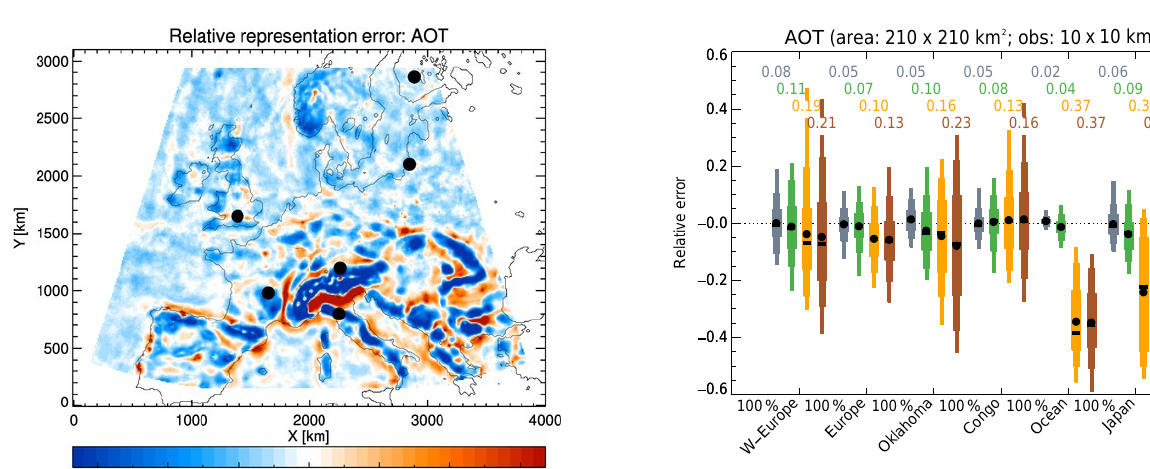
Figure 6. Analysis of monthly representation errors for remote sensing ground sites: purely spatial sampling (grey), spatial sam- pling and the observational cycle (green), spatial sampling and cloudiness (orange), and finally full spatio-temporal sampling (brown). Further explanation in Sect. 3.2.